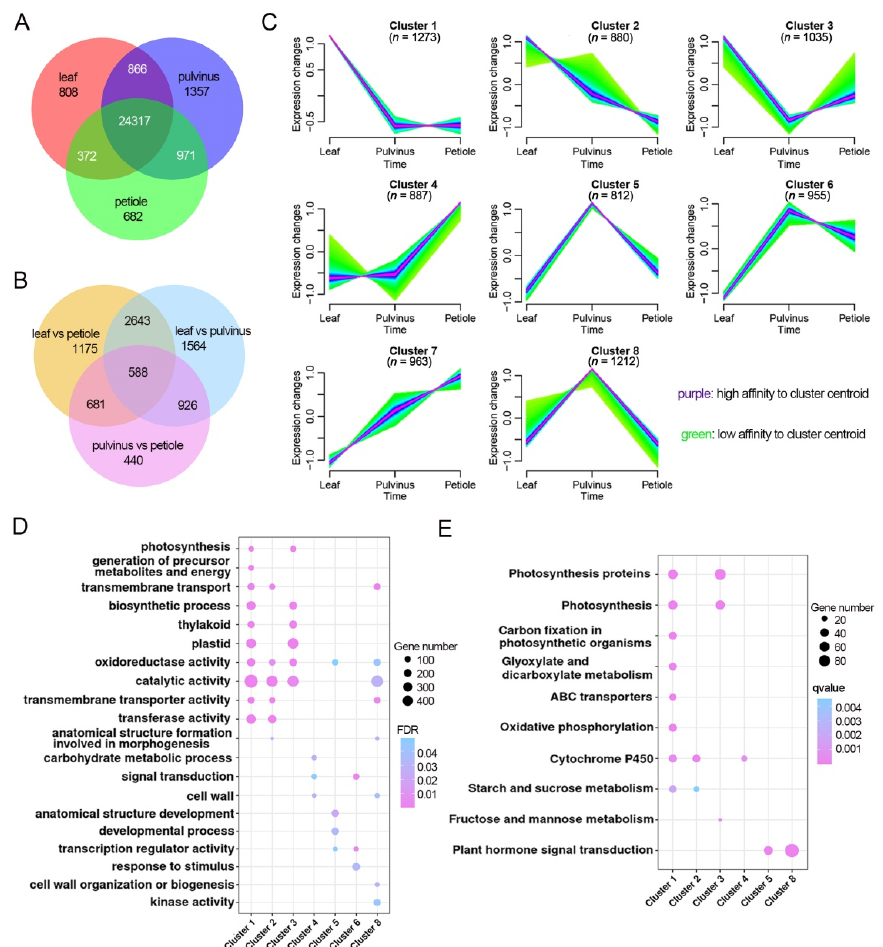
Figure 4. Different gene regulatory landscape of leaflet, pulvinus and petiole tissues. ( A ) The Venn diagram of the mRNA numbers detected in leaflets, pulvini and petioles, respectively. ( B ) The Venn diagram of the differentially expressed genes numbers by comparison among leaflets, pulvini and petioles, respectively. ( C ) Eight expression profile types of differentially expressed genes in ( B ) by fuzzy C ‐ Means clustering. High affinity to the cluster centroid is shown in purple and low in green. ( D , E ) GO enrichment ( D ) and KEGG ( E ) analysis of each expression profile type in ( C ).